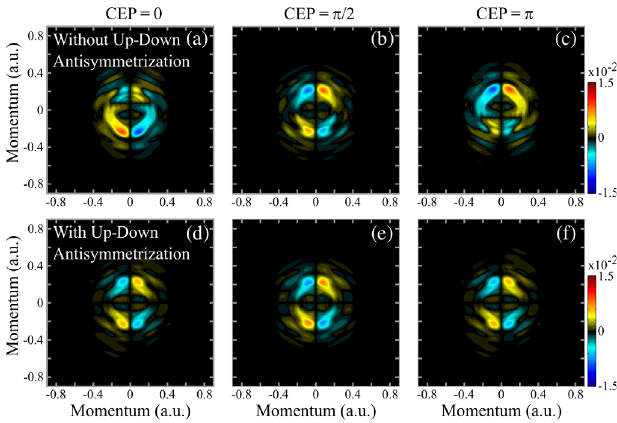
FIG. 7. Influence of the carrier-envelop phase ϕ TDSE calculations at I ¼ 5 × 10 12 W cm − 2 and for a relative phase between the two components of the laser field φ ¼ 3 π = 4